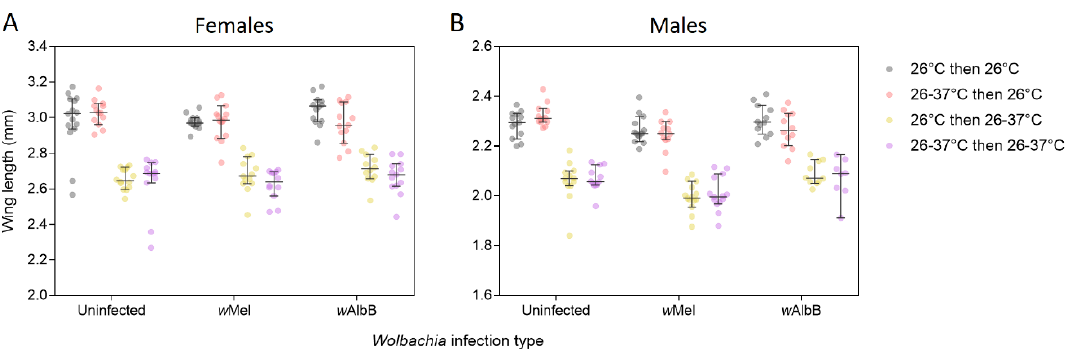
Figure 4. Wing length of female ( A ) and male ( B ) Ae. aegypti from three Wolbachia infection types (uninfected, w Mel-infected or w AlbB-infected) that were reared under different temperature regimes across two generations. Mosquitoes were reared at 26 ◦ C in both generations (gray dots), 26–37 ◦ C in both generations (purple dots), 26–37 ◦ C in the first generation and 26 ◦ C in the second generation (red dots) or 26 ◦ C in the first generation and 26–37 ◦ C in the second generation (yellow dots). Error bars are medians and 95% confidence intervals.